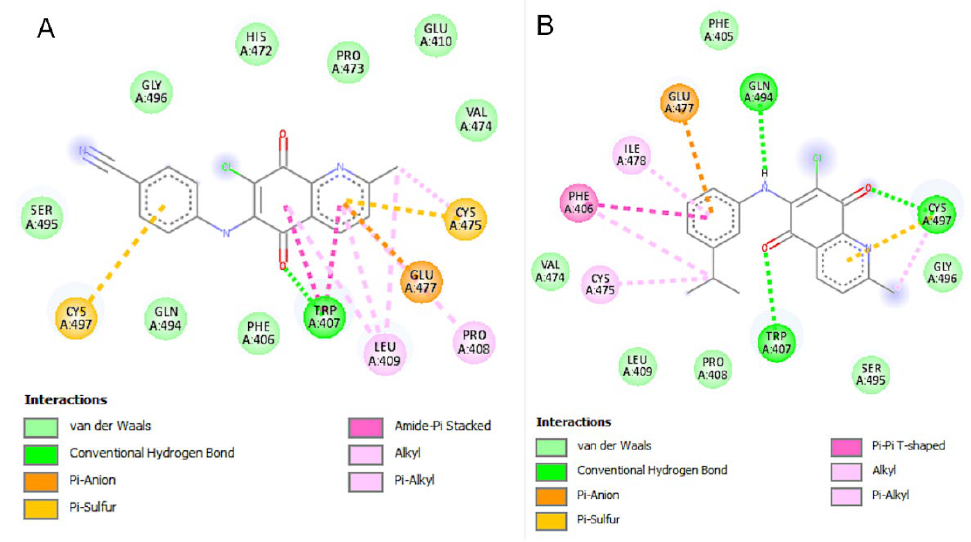
Figure 9. Schematic 2-D representation of protein–ligand interactions between the key residues of Thioredoxin reductase 1 (PDB: 3EAN) binding pocket with ( A ) AQQ4 and ( B ) AQQ9 .